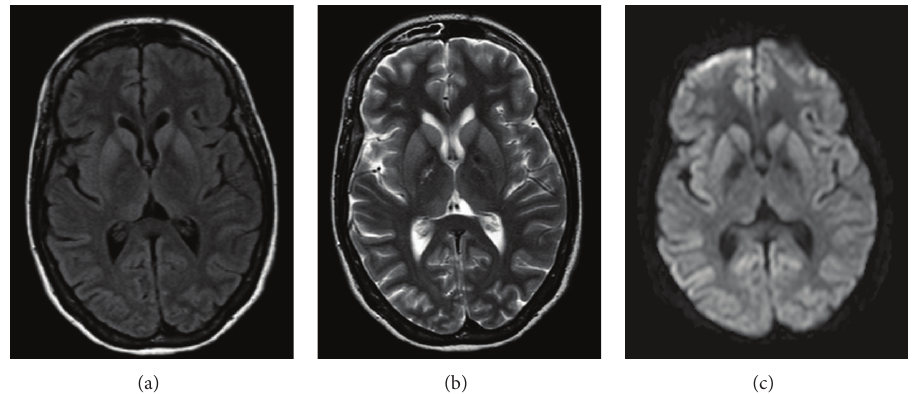
Figure2:MRIfindings(axialFLAIR,T2,andDWI).Subtlesymmetricalhyperintensitiesinthecaudatenucleusandputamenandlessevident in the pulvinar nuclei and cerebral cortex are noticeable.The figure is constructed by J.